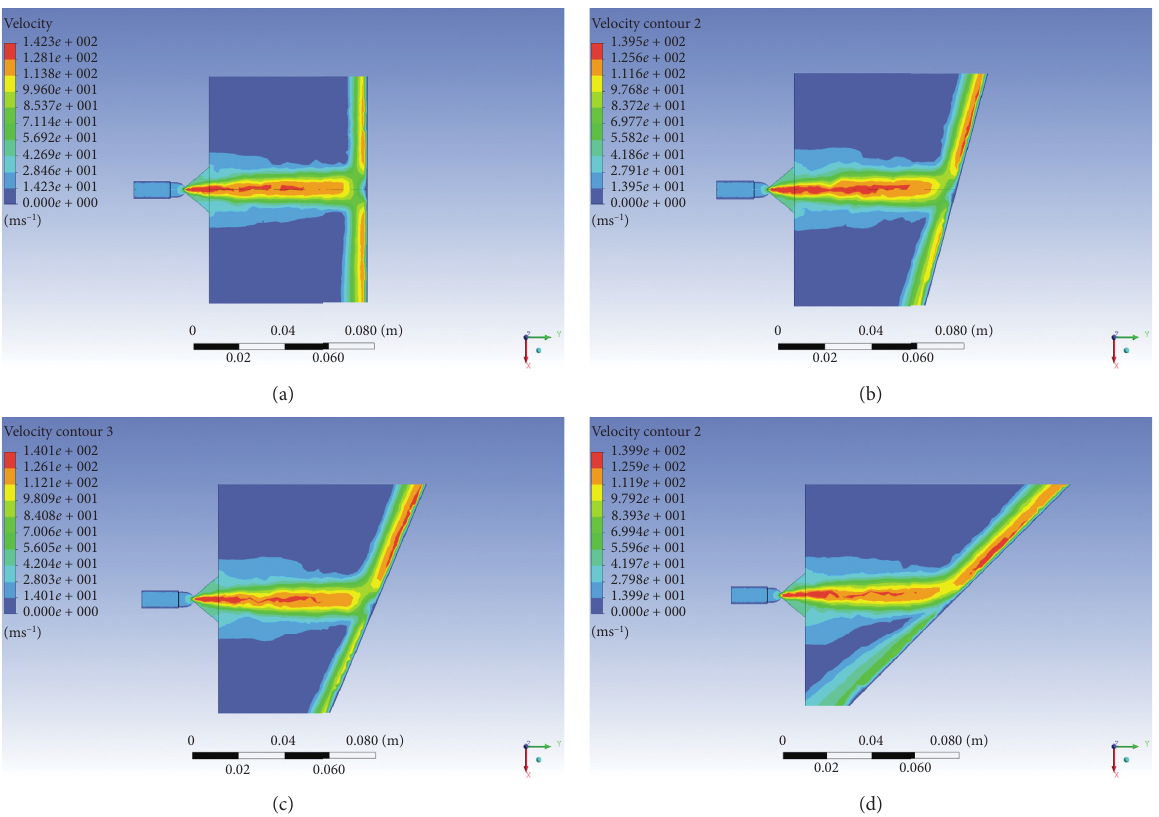
Figure 13: Velocity nephogram at different angles. (a) 0 ° . (b) 15 ° . (c) 30 ° . (d) 45 ° .